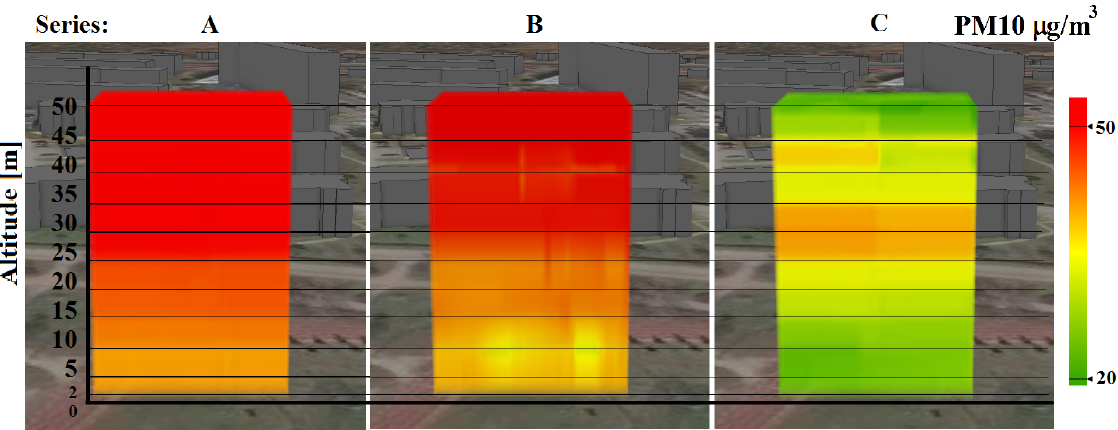
Figure 5. Spatial distribution of PM 10 pollution with altitude for three measurement series in the VEIP station area.